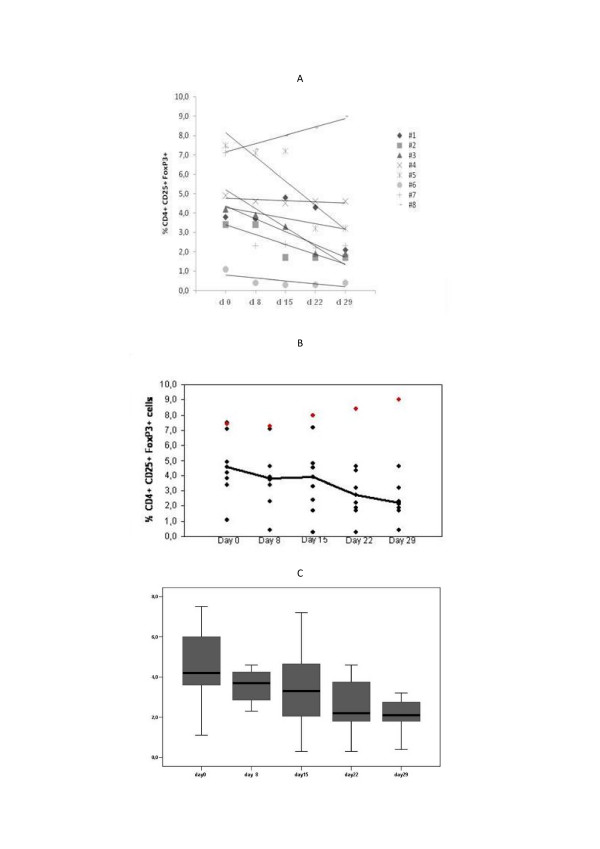
A-B-C. Levels of circulating Treg cells (CD4+CD25+FoxP3+) in the blood of melanoma patients during the four weeks of HDI IV induction therapy. The peripheral blood assays have been performed at the start of each week of treatment (Day 0, 8, 15, 22) and after the last week (on Day 29). (A) Trend in a single patient; (B) trend of the average value of Treg cells during HDI IV treatment; (C) Boxplot summarizing the data observed in the cohort of patients during the initial 4 weeks of treatment.